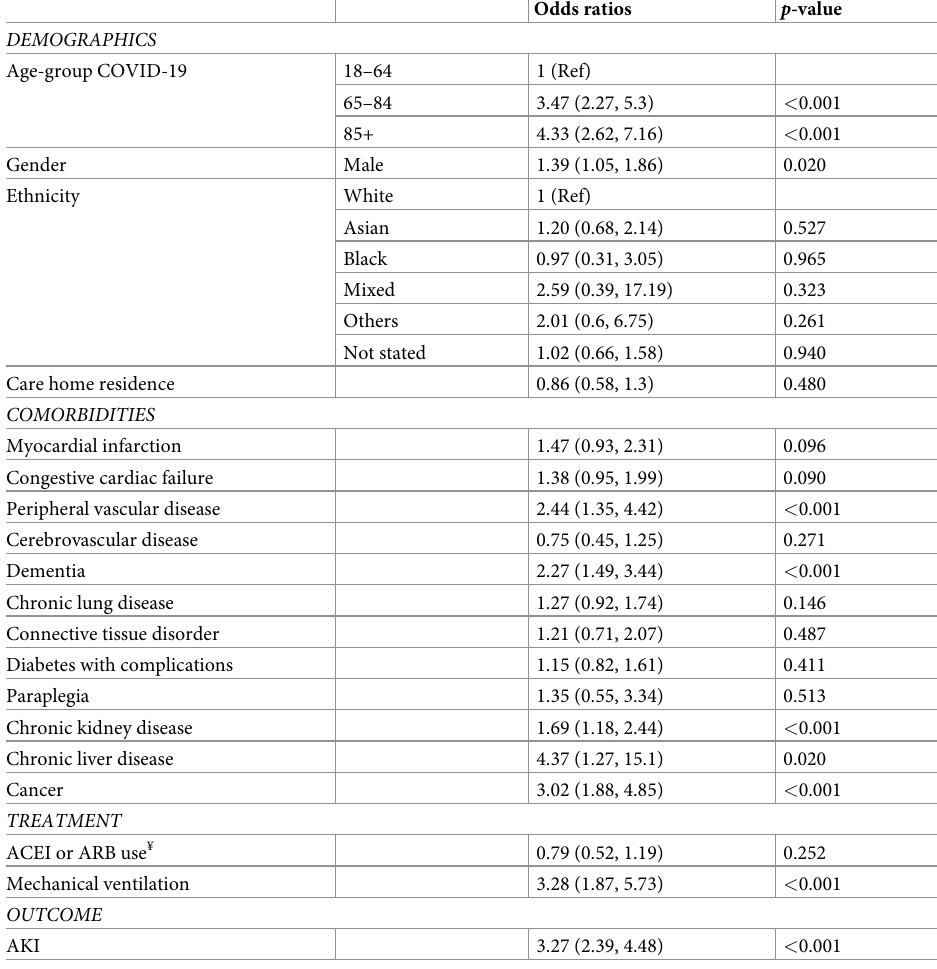
Table 3. Multivariable logistic regression to identify risk factors for mortality in COVID-19